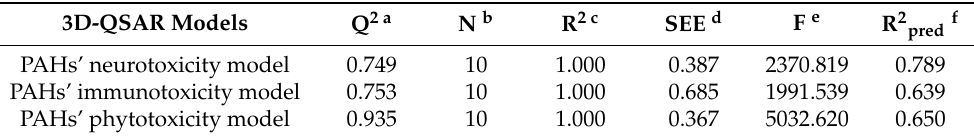
Table 2. Evaluation parameters of 3D-QSAR models for PAHs’ neurotoxicity, immunotoxicity and phytotoxicity.